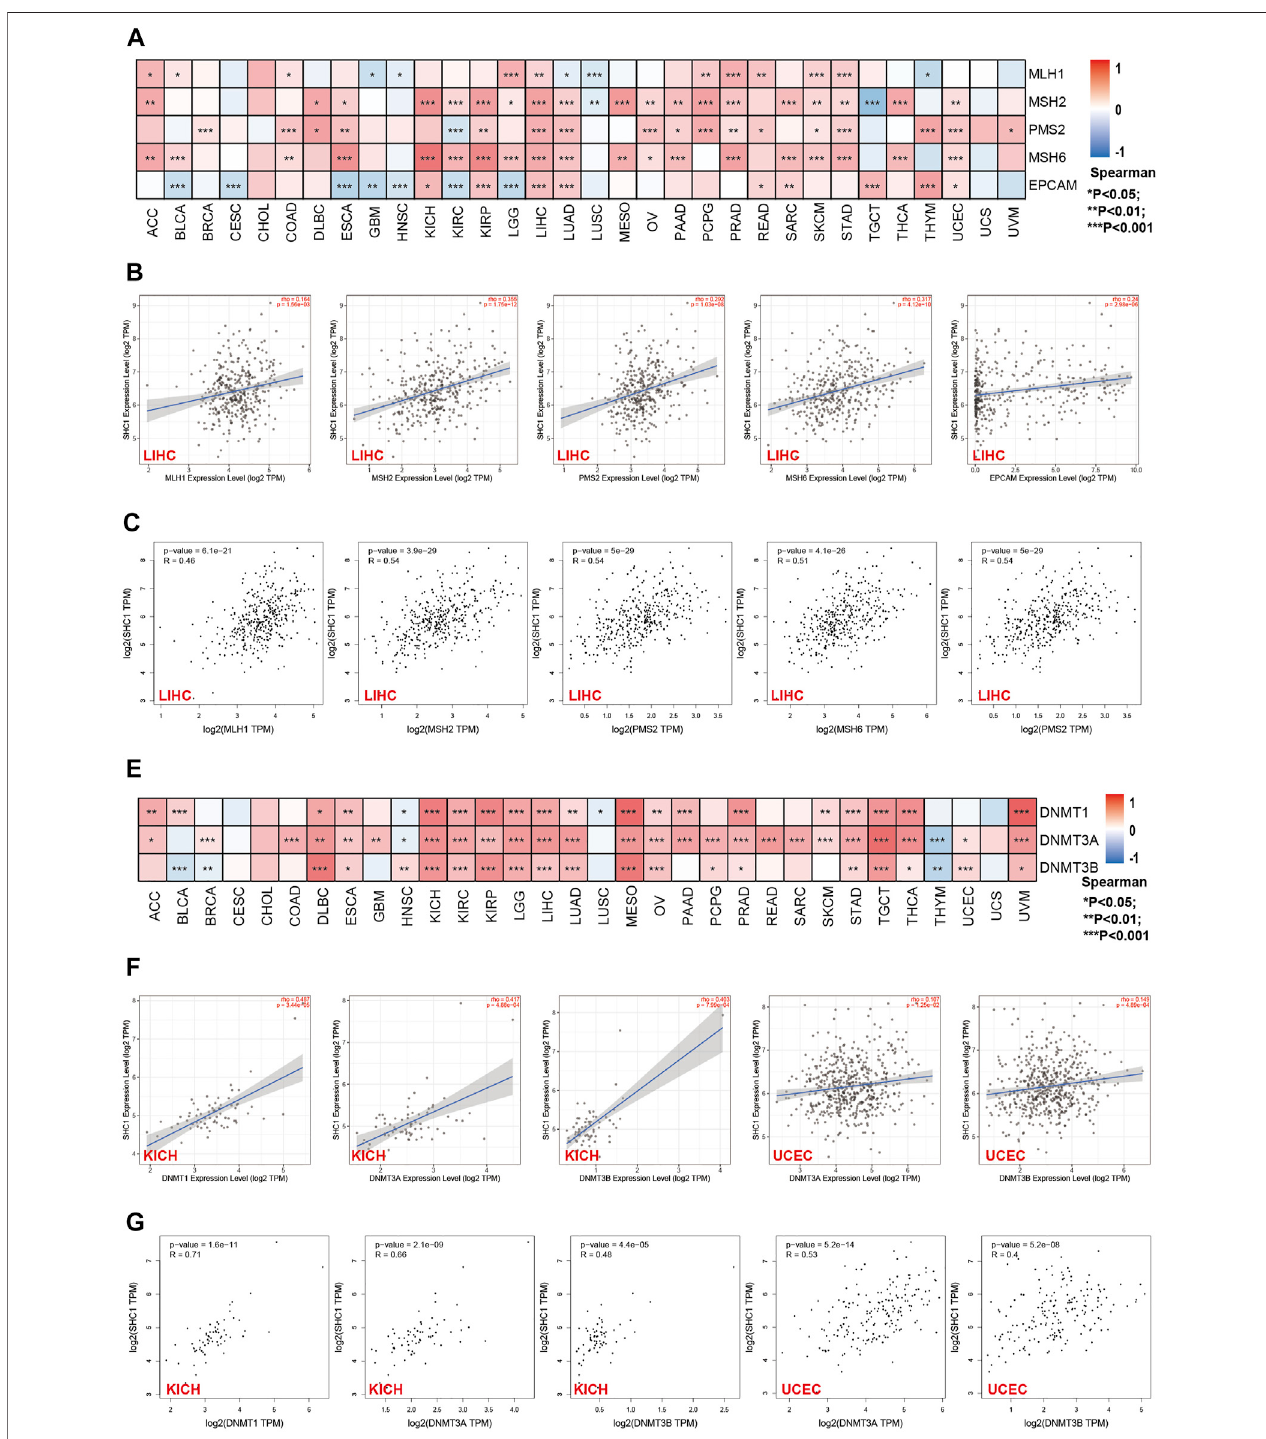
FIGURE 4 | Correlation between SHC1 expression and the expression of MMRs and DNMTs genes in various cancers. (A) Heatmap showing the Spearman correlation analysis of SHC1 expression and the levels of fi ve MMR genes (MLH1, MSH2, MSH6, PMS2, and EPCAM) in pan-cancer. Correlation between SHC1 expression and expression ofMMR genesin LIHC plotted using TIMER2.0 (B) and con fi rmed via GEPIA2 (C) . Heatmap showing the Spearman correlation between the SHC1 expression and of the expression of three DNA methyltransferase (DNMT1, DNMT3A, and DNMT3B) genes in pan-cancer (E) . Correlation between SHC1 expression and expression of DNA methyltransferase genes in LIHC and UCEC plotted using TIMER2.0 (F) and con fi rmed via GEPIA2 (G) . (* p < 0.05, ** p < 0.01, and *** p < 0.001).